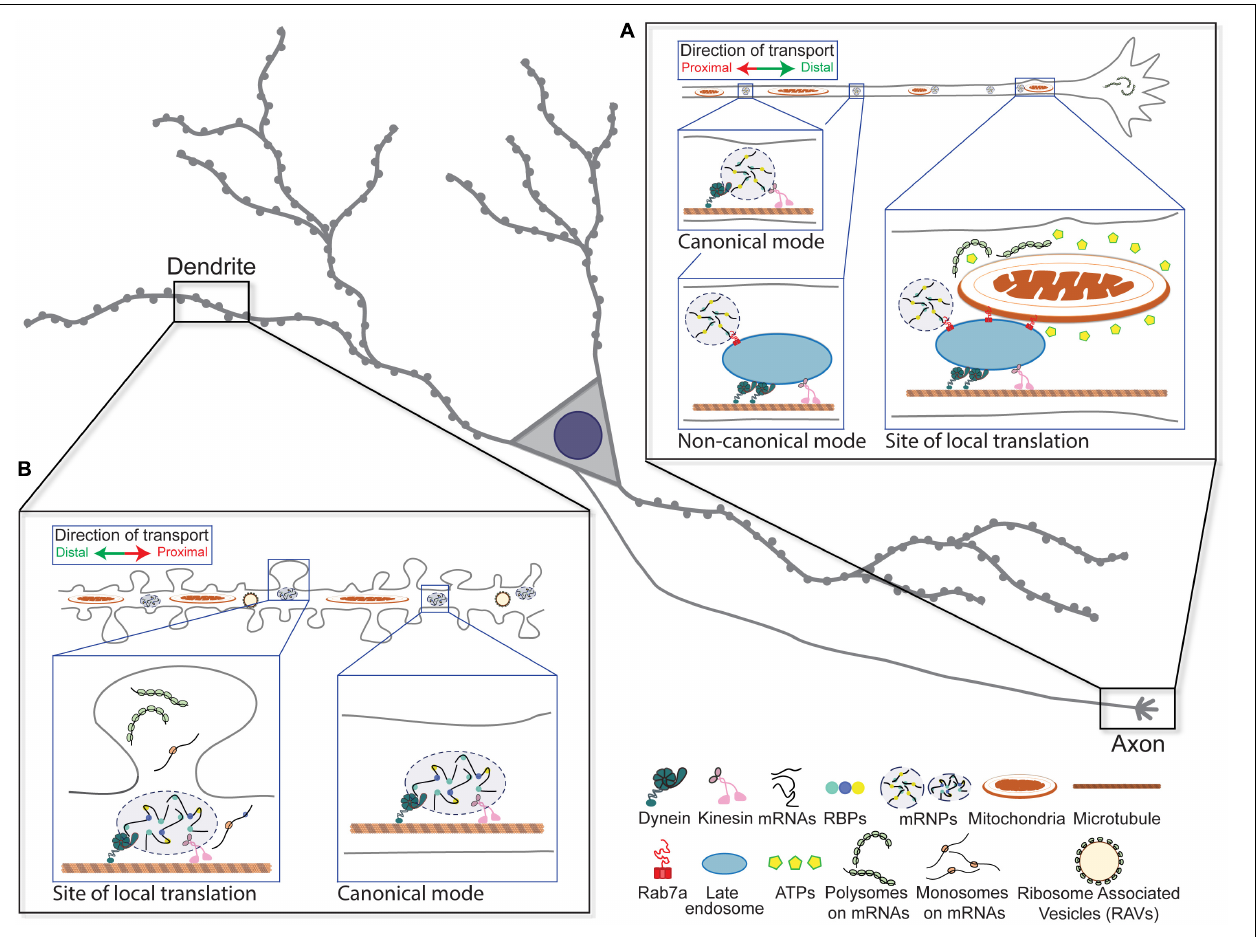
FIGURE 1 | Canonical and non-canonical modes of the long-range transport of messenger ribonucleoprotein (mRNPs) in neurons. (A) Molecular motor-based canonical and non-canonical modes of mRNP transport in axon are depicted. Local translation of mRNAs through the interaction among mRNP, late endosome, and mitochondria at the distal site of axon is illustrated. (B) Molecular motor-based long-range transport of mRNPs in dendrites is indicated. Local translation in and near the base of activated spines is